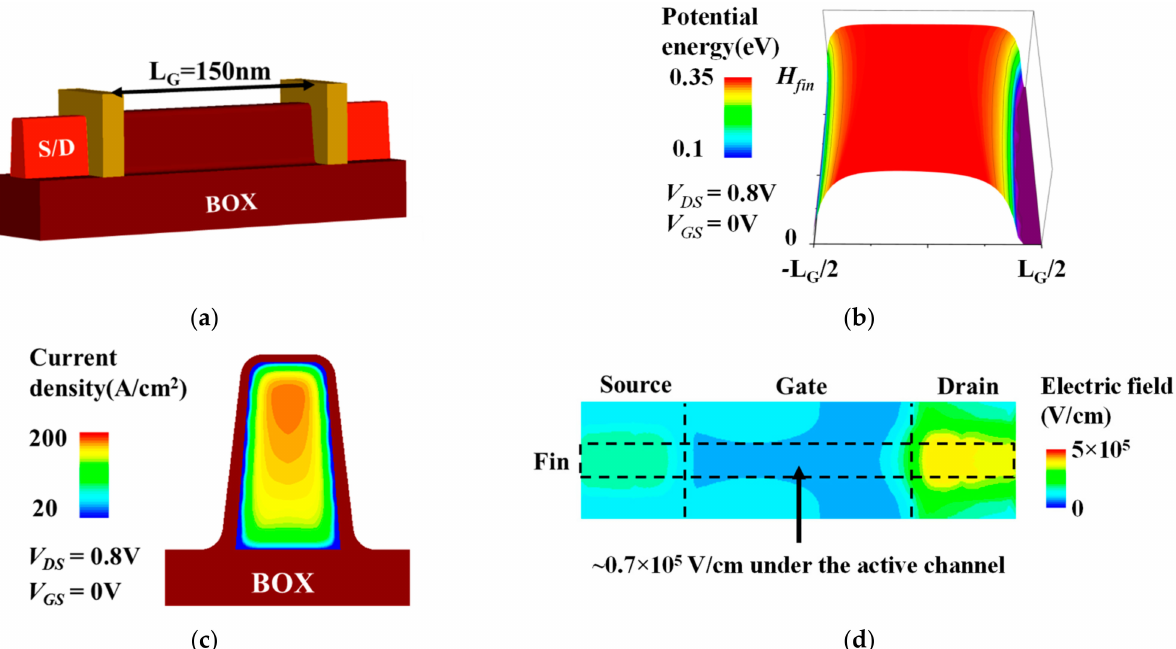
Figure 5. Simulation results of a long channel ( L G = 150 nm) SOI n-FinFET. ( a ) Schematics of the simulated device, ( b ) the potential energy distribution in channel region, ( c ) the sub-threshold current distribution in the tapered fin and ( d ) the distribution of the electric field in the BOX perpendicular to the channel/BOX